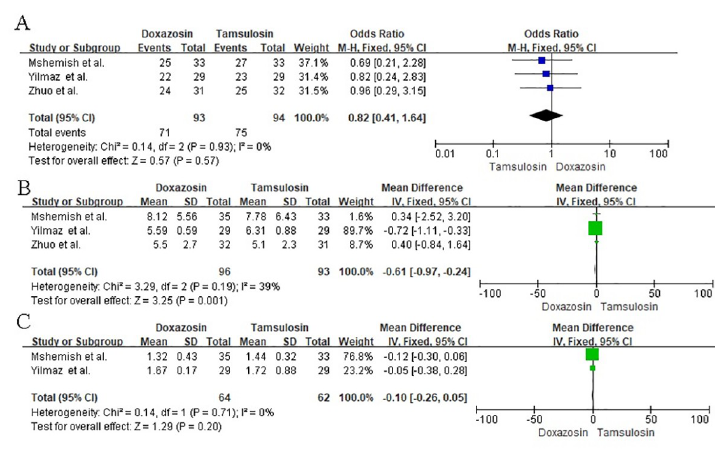
Fig 6. A: Meta-analysis results of expulsion rate between the groups. B: Meta-analysis results of expulsion time between the groups. C: Meta-analysis results of pain episodes between the groups.